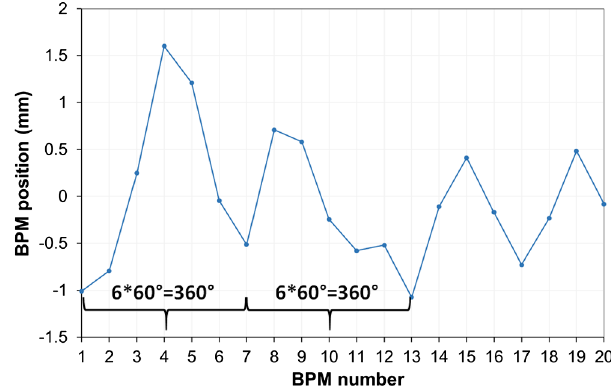
FIG. 7. Vertical beam position along the SC linac for the 16 kW beam.